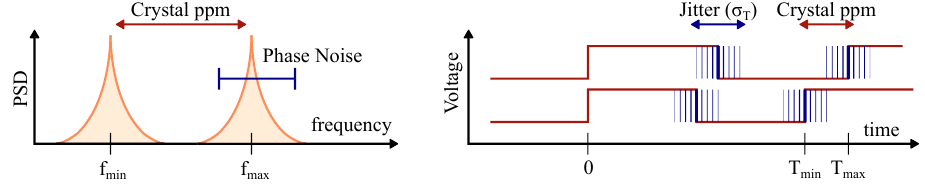
Figure 13. Visual representation of the reference crystal non-idealities. Phase noise in frequency domain is equivalent to jitter in the time